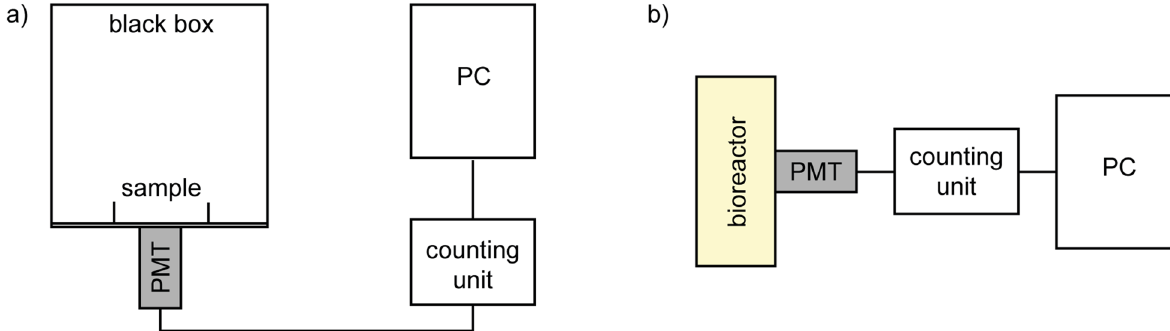
Figure 5. A scheme of the experimental setup for the measurements of BAL during ( a ) induced oxidation in a Petri dish in a black box and ( b ) spontaneous oxidation in a bioreactor. The bioreactor with the photodetector chamber was light-isolated by a black cloth